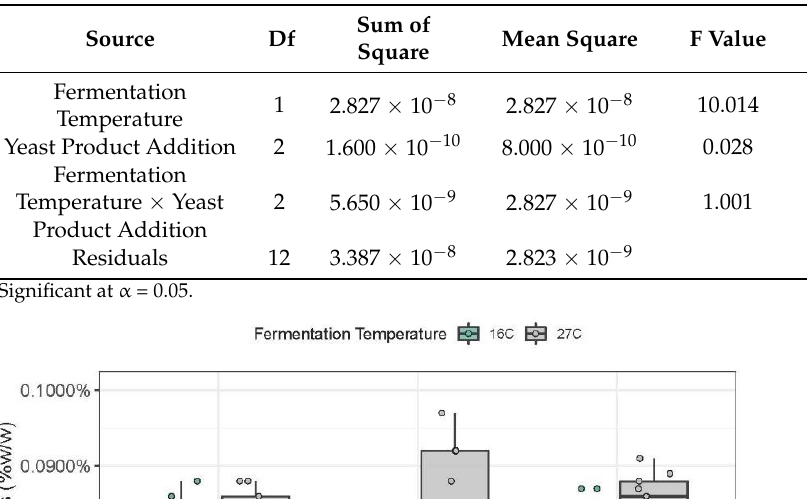
Table 3. Two-way ANOVA table for fermentation temperature and yeast product addition facto- rial experiment.